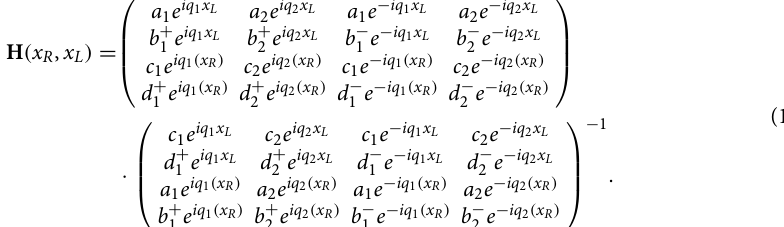
Fig. 1d. The explicit expressions for the vectors F u ( x ) and F d ( x ) can be found in Ref. 41. Then from equations (10) and (11), the hybrid matrix can be written